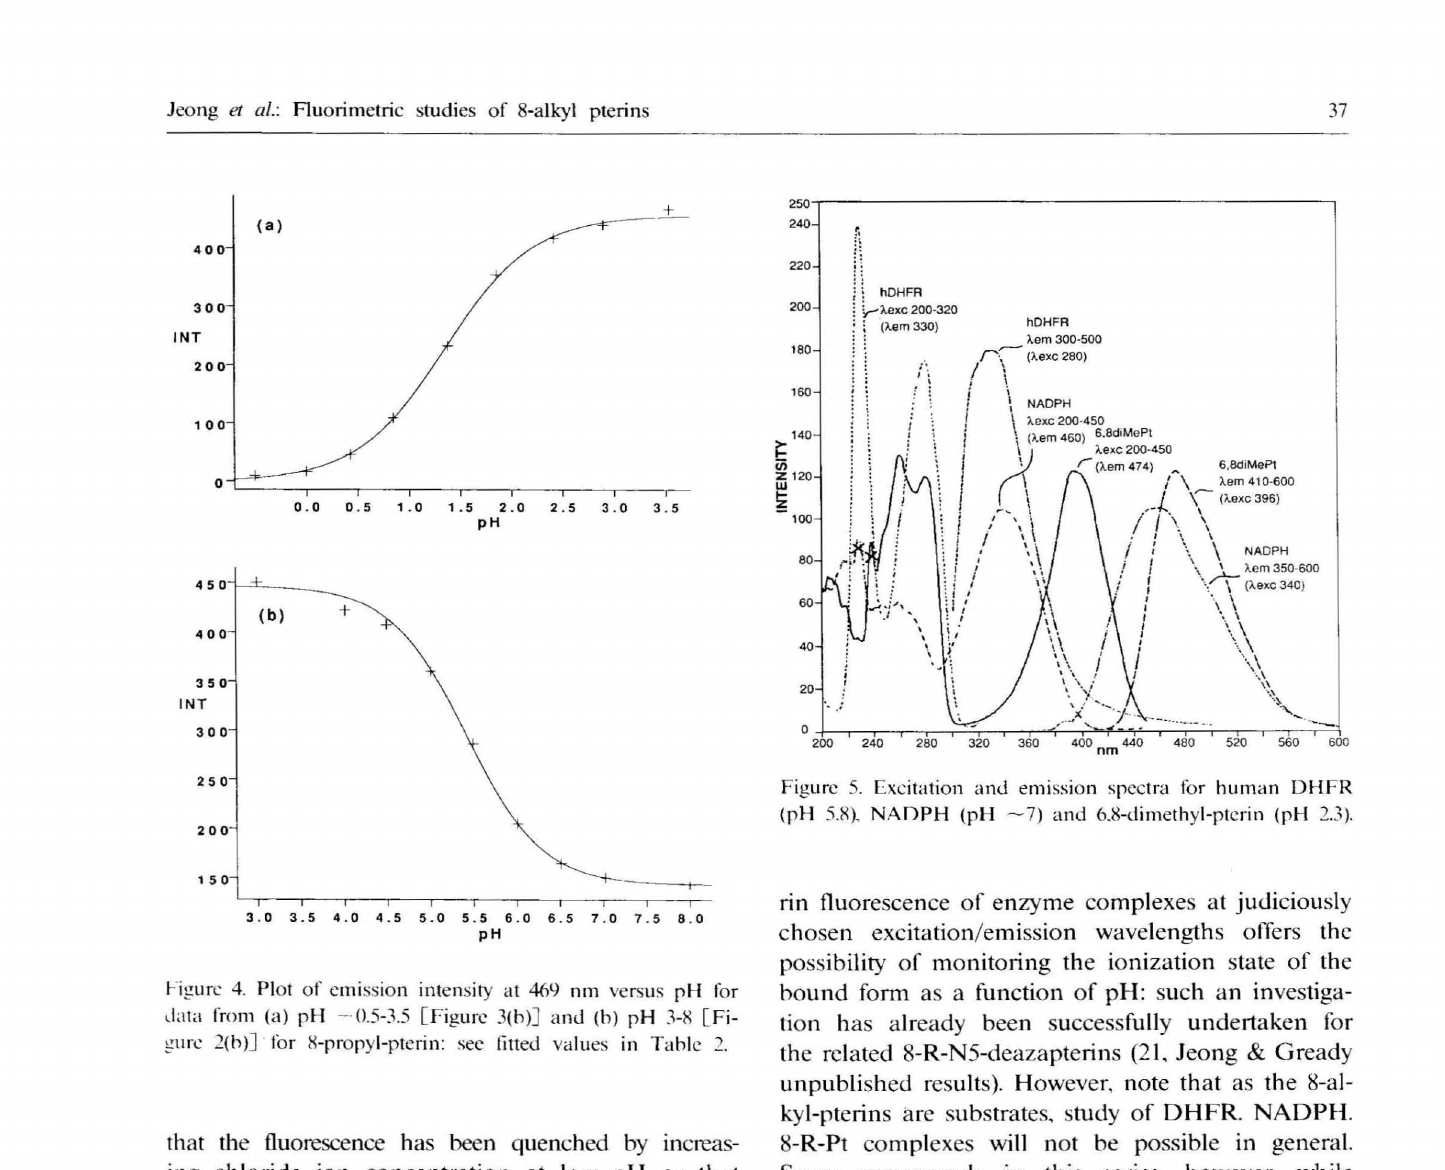
Figurc 4. Plot of emission intensity at 469 nm versus pH for data from (a) pH -' 0.5-3.5 [Figure 3(o)J and (b) pH 3-X [Fi gun: 2(o)J for X-propyl-pterin: see litted values in Table 2.